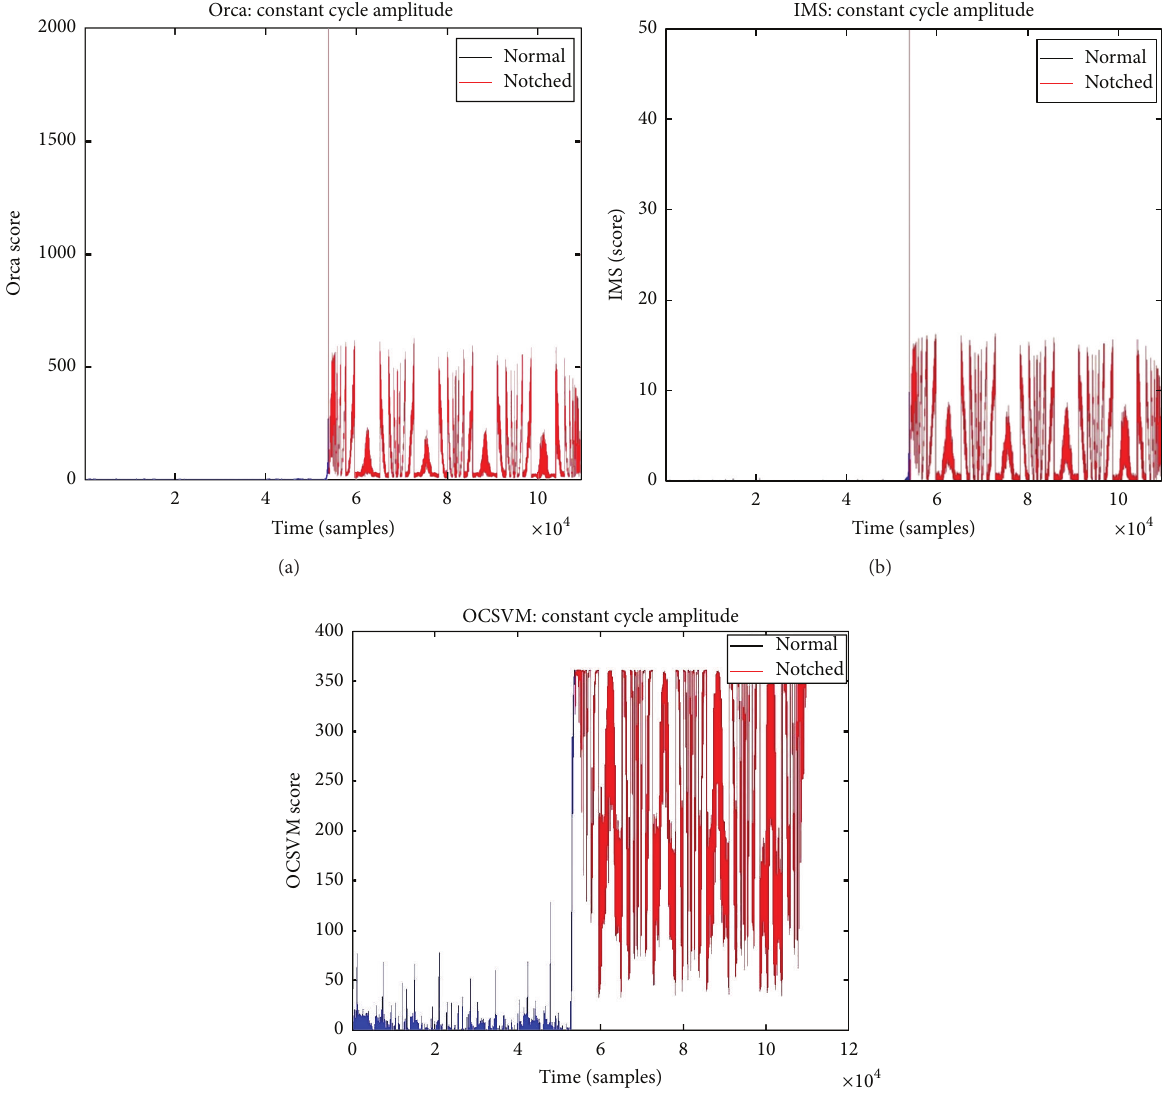
Figure 11: Results of the data driven anomaly detection techniques. (a) Orca. (b) IMS. (c) OCSVM.